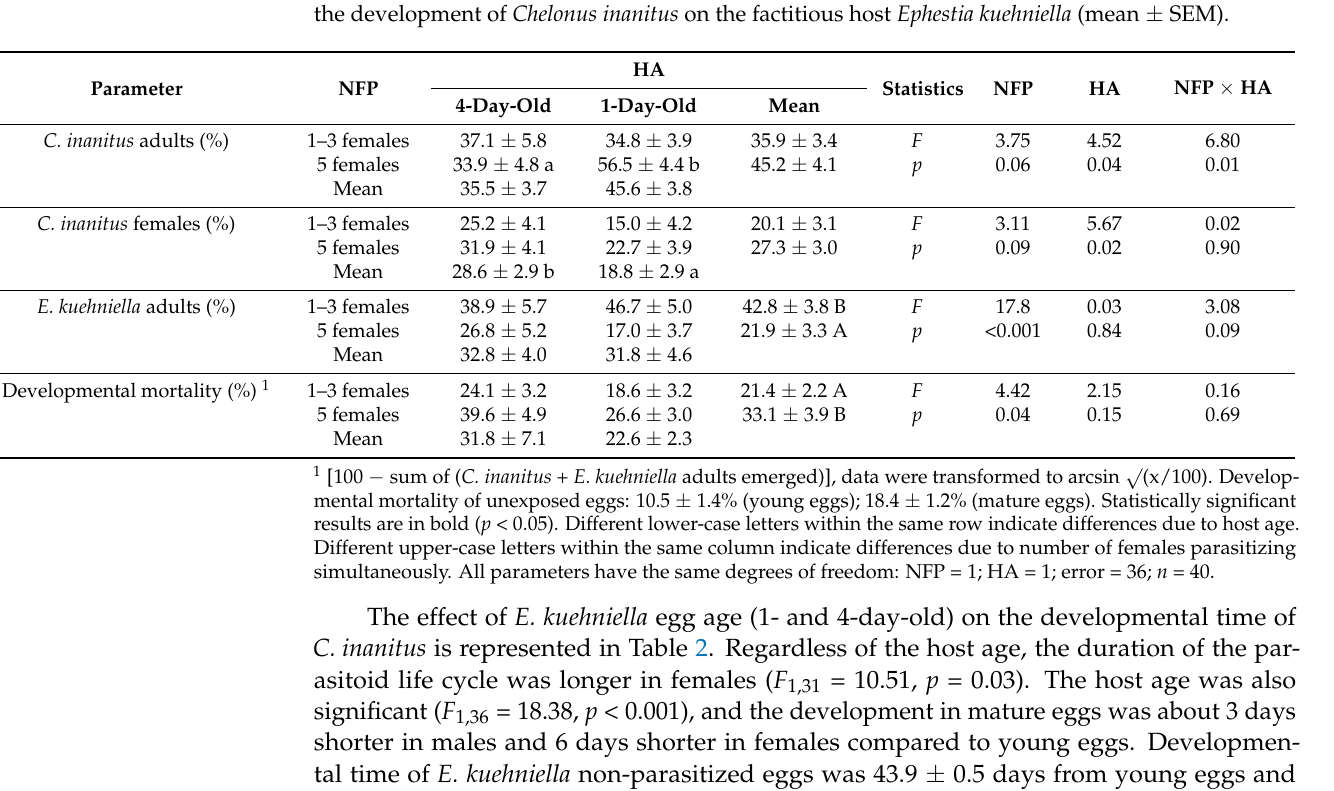
Table 1. Influence of the number of females parasitizing simultaneously (NFP) and host age (HA) on the development of Chelonus inanitus on the factitious host Ephestia kuehniella (mean ± SEM).